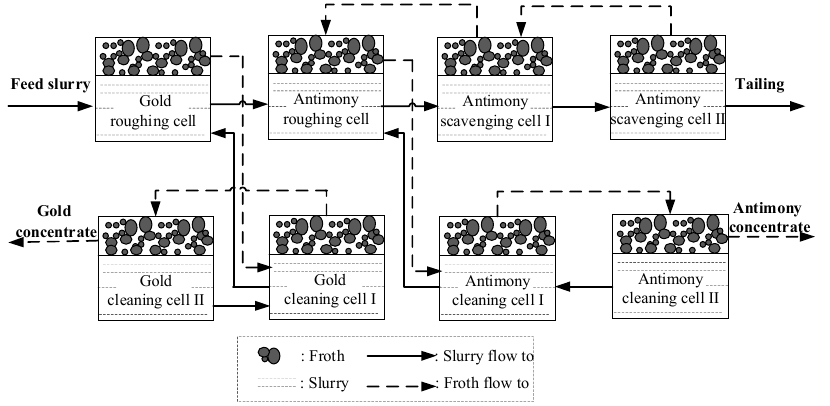
Figure 1. Process diagram of gold-antimony flotation.